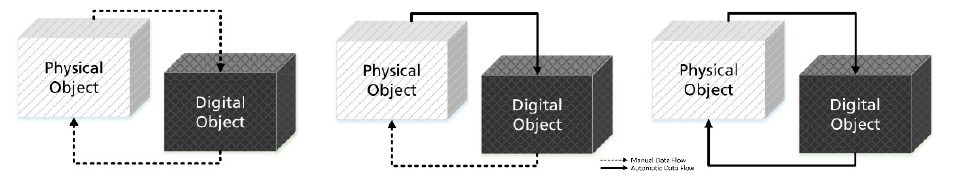
Figure 1. Digital Model (left), Digital Shadow (middle), Digital Twin (right) [21]. One of the main revolutions brought by the I4.0 is the introduction of the XR technolo- gies. The term XR defines a spectrum containing AR, MR and VR paradigms, from the least to the most immersive one. The term augmented reality is first introduced in 1992 by Caudell and Mizell [23] to define virtual objects as overlapping with their users’ real